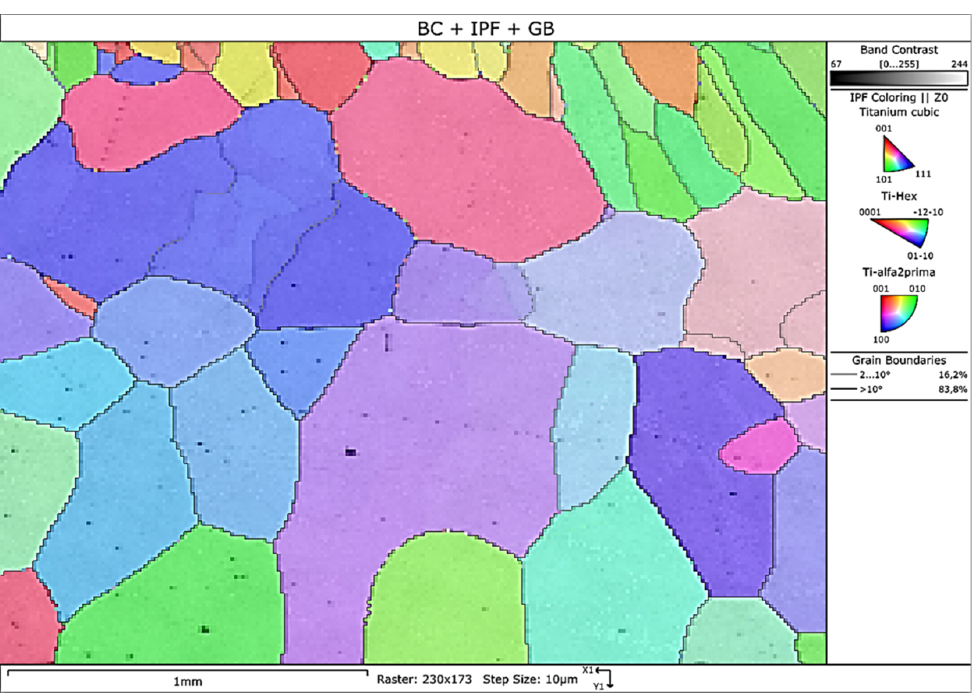
Figure 4. The EBSD analysis of as-cast TNZT with the inverse pole figure referring to the Ti cubic structure.